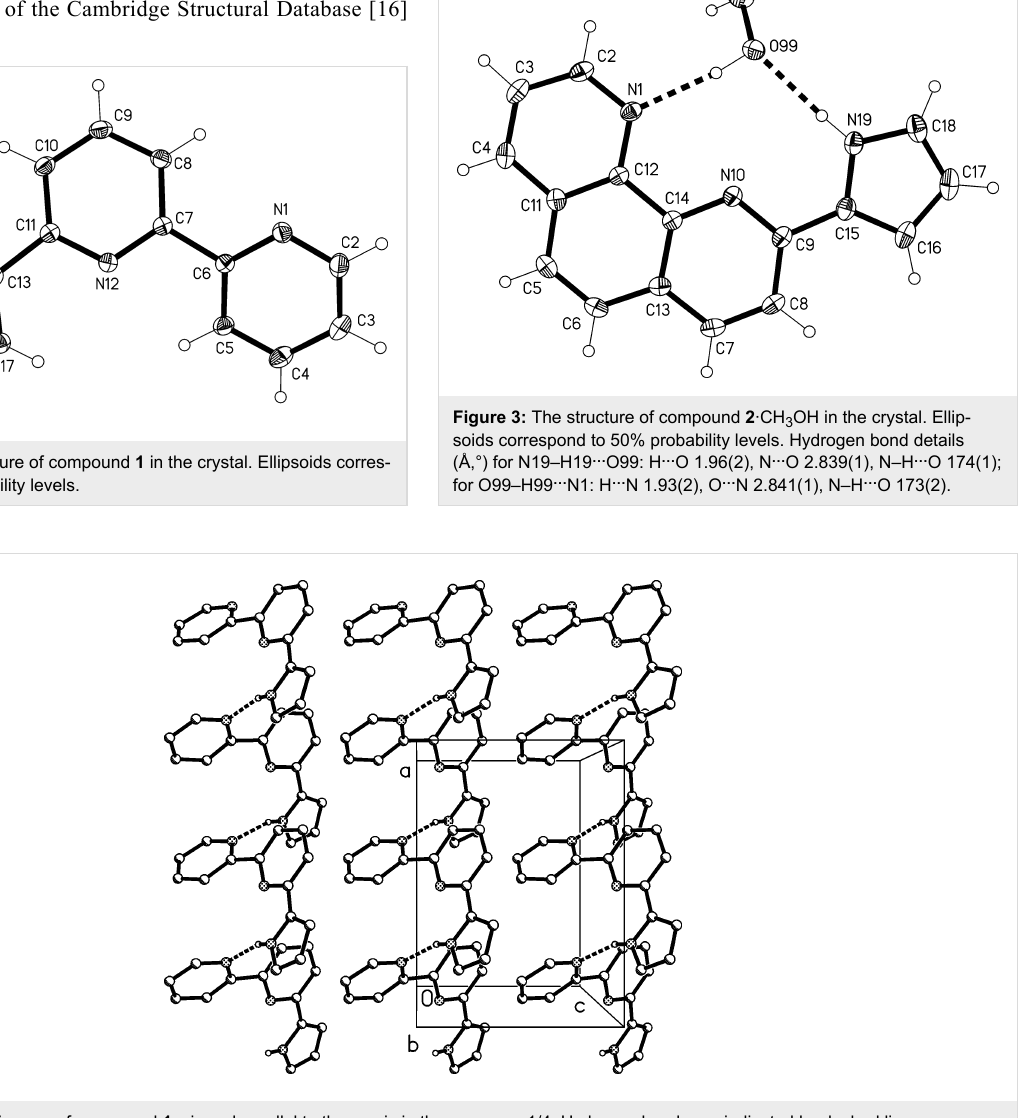
Figure 2: Packing diagram of compound 1 , viewed parallel to the y -axis in the range y ≈ 1/4. Hydrogen bonds are indicated by dashed lines. Hydrogen atoms not involved in the hydrogen bonds are omitted for clarity. Hydrogen bond details (Å,°) for N17–H17 … N1: H … N 0.88(2), N … N 2.861(2), N–H … N 158(2), operator 1/2 + x , 1 1/2 − y , z .